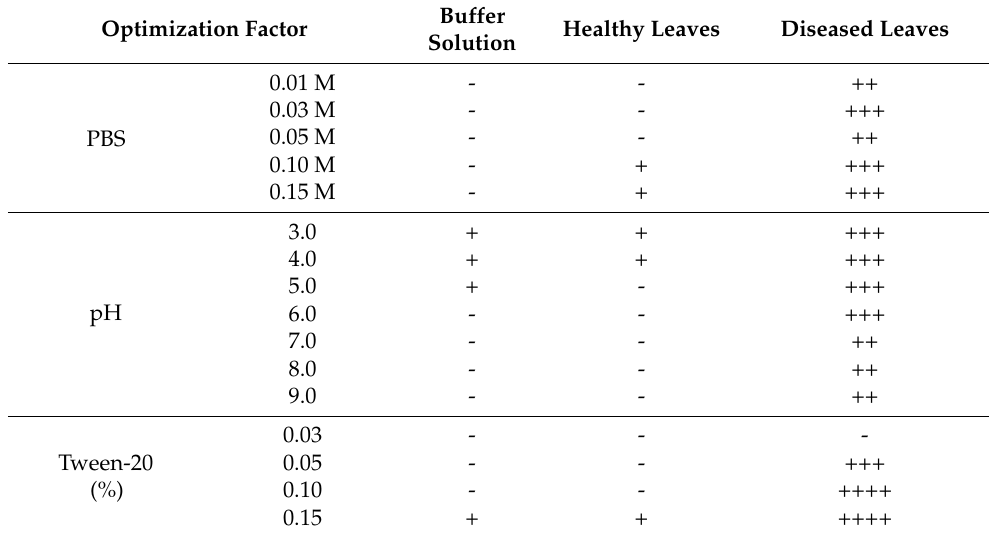
Table 1. Effect of different buffer parameters on the test strip results. Buffer Healthy Leaves Diseased Leaves Optimization Factor Solution 0.01 M - - ++ 0.03 M - - +++ 0.05 M - - ++ PBS 0.10 M - + +++ 0.15 M - + +++ 3.0 + + +++ 4.0 + + +++ 5.0 + - +++ pH 6.0 - - +++ 7.0 - - ++ 8.0 - - ++ 9.0 - - ++ 0.03 - - - Tween-20 0.05 - - +++ (%) 0.10 - - ++++ 0.15 + +